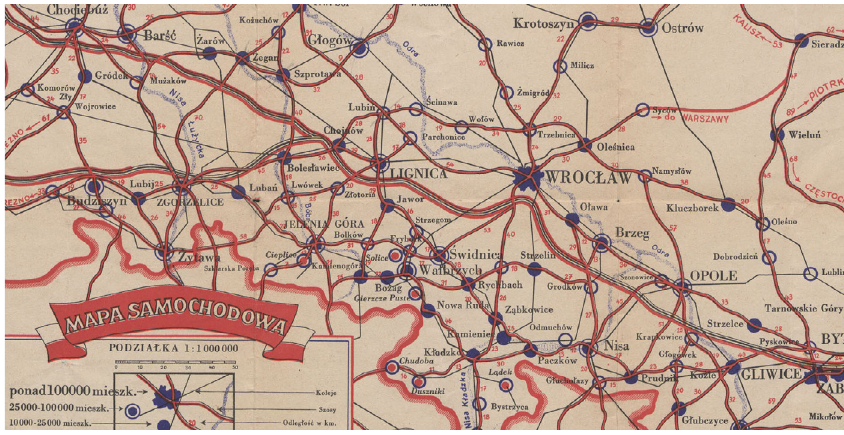
Fig. 1. Part of a map Dolny Śląsk. Mapa samochodowa , 1:1,000,000,